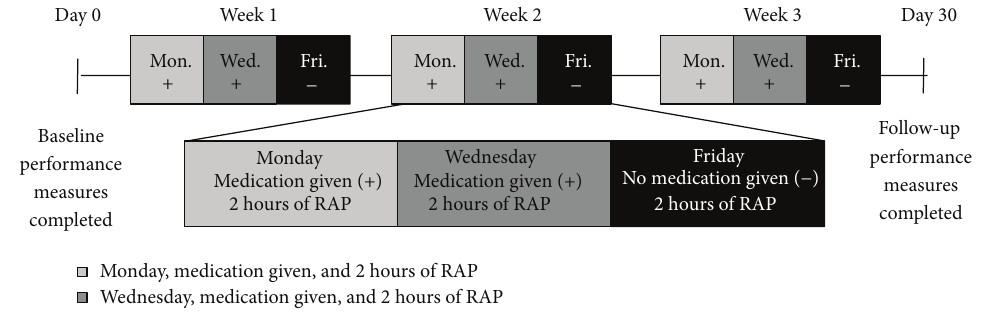
Figure1:Experimentaldesignandtimecourseofthestudy.Aftercompletingbaselinetesting,therewere6visitsatwhichmedication(placebo or D-cycloserine at 100mg dose) was dispensed. Dosing was oral and twice weekly (Monday and Wednesday) throughout the study. The study design included one session per week (Friday) in which the drug was not dispensed. Volunteers received medication immediately preceding the robotic training sessions. Final examination was administered on Day 30. + indicates medication given and − indicates no medication given. RAP: robotic-assisted